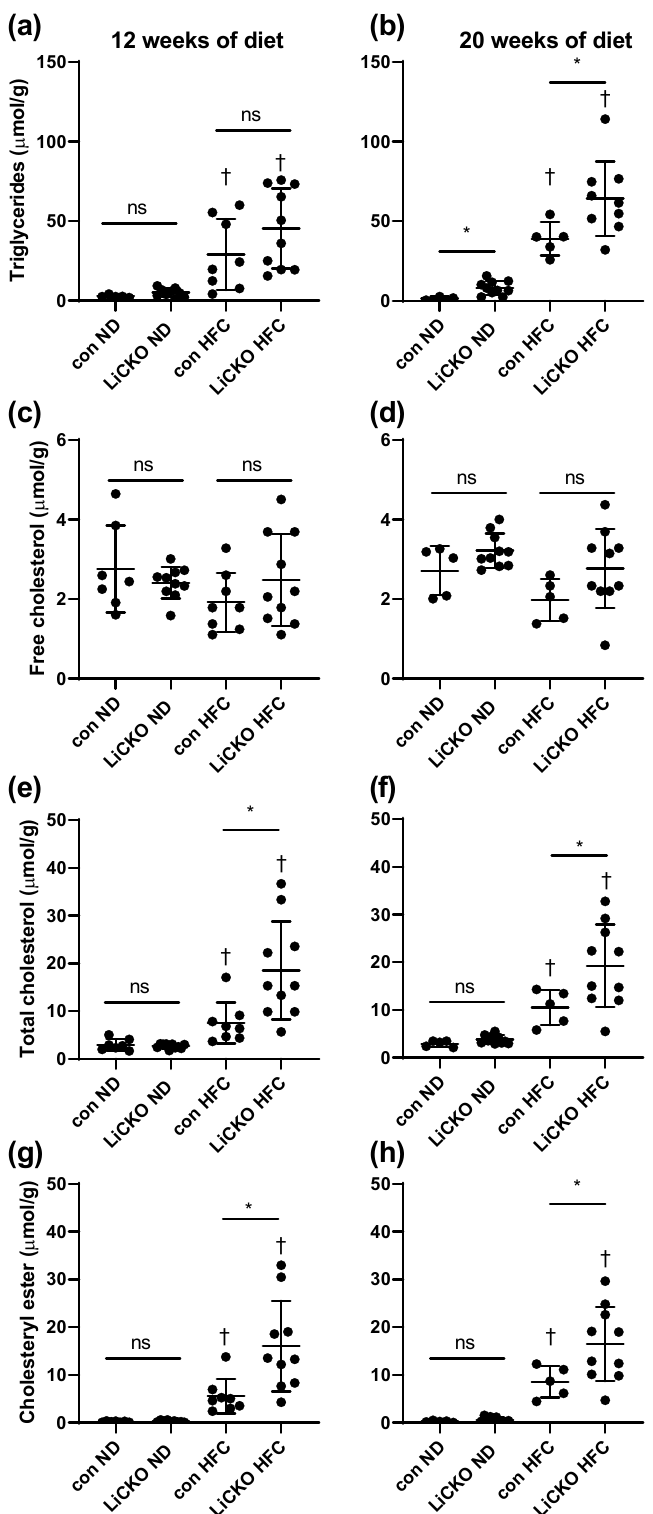
Figure 5. Liver triglyceride and cholesterol levels at weeks 12 and 20 of diet. ( a , b ) Liver triglyceride levels; ( c , d ) free cholesterol levels in liver; ( e , f ) total cholesterol and ( g , h ) cholesteryl levels. * p < 0.05 difference between con and LiCKO on same diet; † p < 0.05 difference between ND and HFC for con or LiCKO; ns = non-significant.